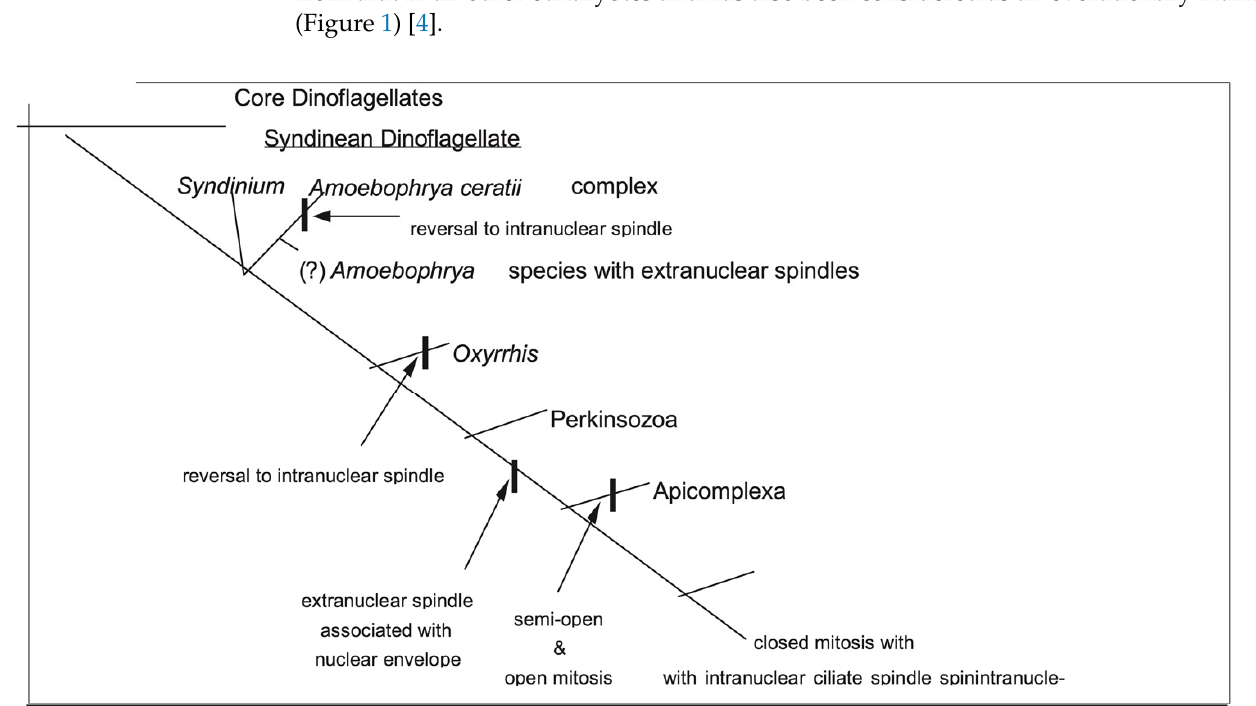
Figure 1. Evolution of the mitotic apparatus in alveolates according to the phylogeny of Bachvaroff et al. [2], reprinted/adapted with permission from Ref. [4].